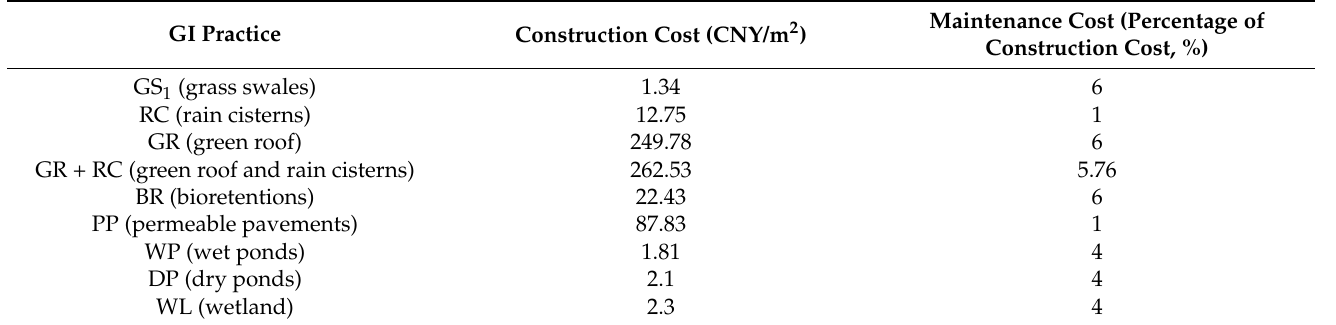
Table 1. Initial construction cost and maintenance cost per drainage area of each GI practice